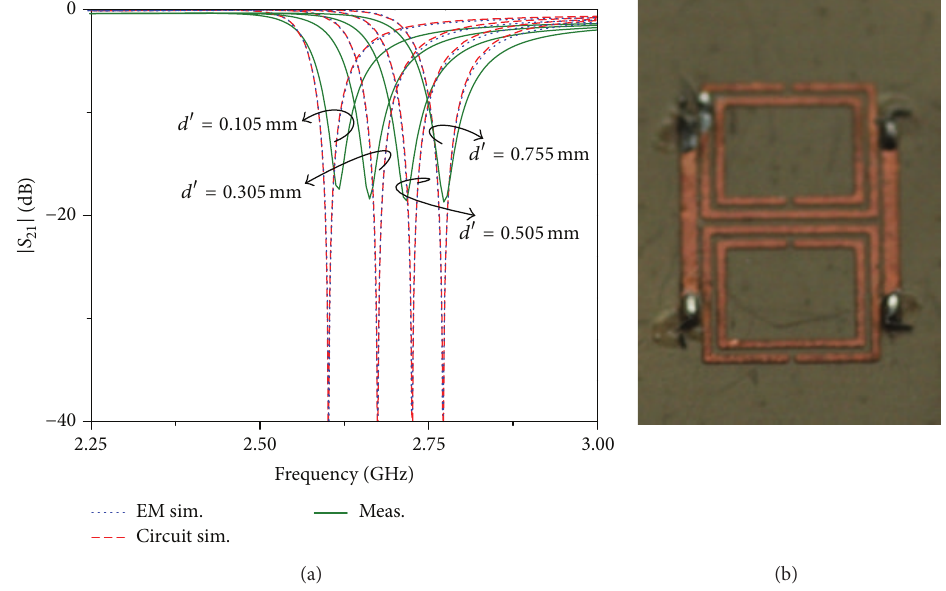
Figure 12: Frequency response for different values of 𝑑 󸀠 (a) and detail of the bottom side of one of the fabricated samples (b). In reference to Figure 10(a), dimensions are 𝑙 1 = 4.8 mm, 𝑙 2 = 3.8 mm, 𝑐 = 𝑑 = 0.2 mm, 𝑙 = 5.6 mm, 𝑊 = 3 mm, and 𝐺 = 1.01 mm. The circuit parameters are listed in Table 1. From [43], reprinted with